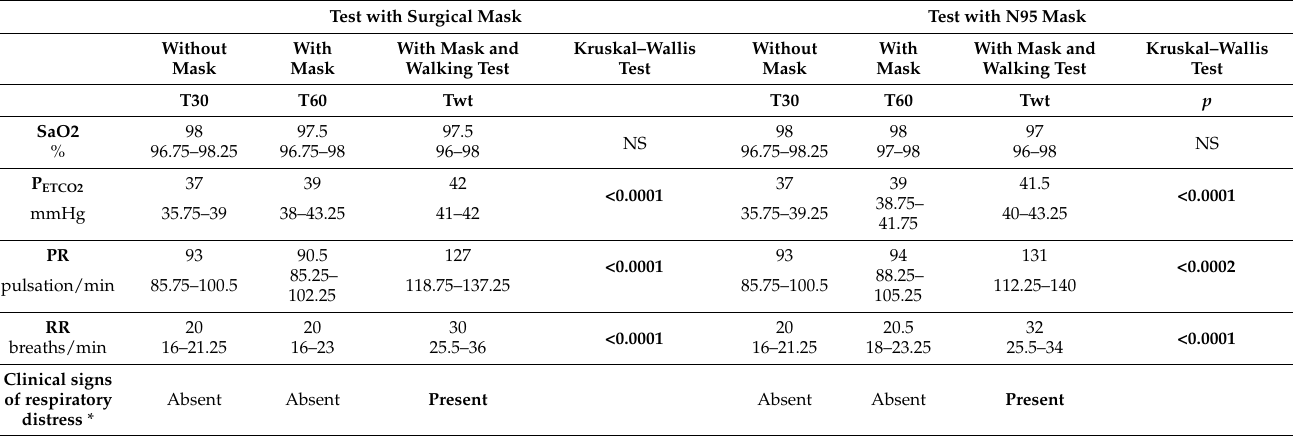
Table 3. Oxygen saturation (SaO2), partial pressure of end-tidal carbon dioxide (P ETCO2 ), pulse rate (PR), respiratory rate (RR) and the occurrence of clinical signs of respiratory distress during the test, at 30 (cid:48) (T30), 60 (cid:48) (T60) minutes and after a 12 min walking test (Twt) in all overweight and obese patients wearing a surgical mask (SM) and N95 mask (N95). All data were expressed as median, 25th and 75th quartile.